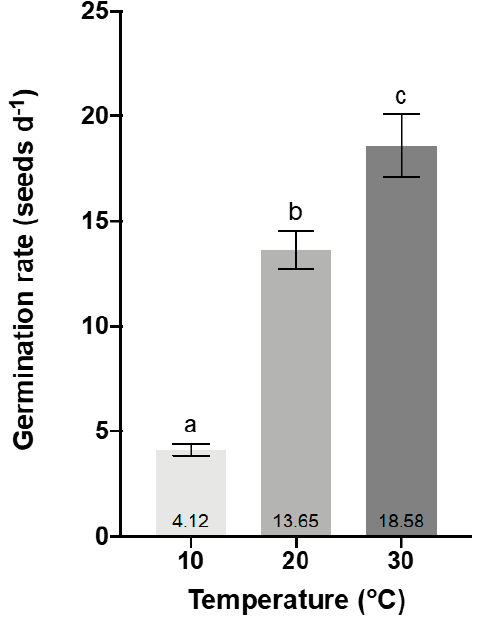
Values are expressed as mean ± SD of five independent replicates. Statistical analysis was per- formed using Kruskal-Wallis ( p < 0.001) followed by a Dunn’s test multiple comparison test. Aster- isks indicate significant differences between treatments (*** p < 0.001).